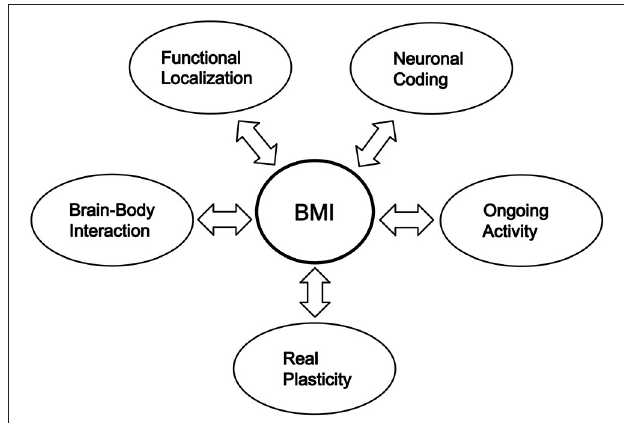
FIGURE 1 | Interactive advancement of researches on BMIs and the principal mysteries of the brain